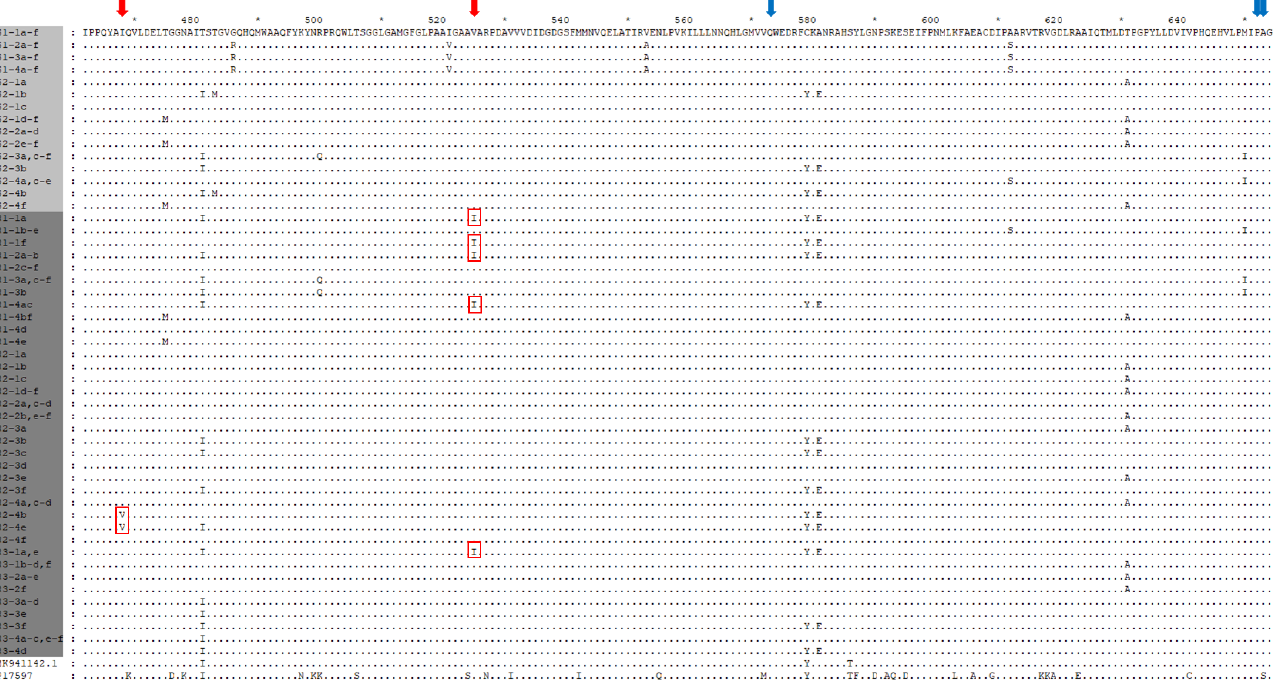
Figure 3. The alignment of Centaurea cyanus ALS amino acid sequences encompassing thiamine pyrophosphate binding domain. The sequences were derived from the plants susceptible (S) and resistant (R) to Lumer 50 WG. The numbers in sequence names represent the plant number; a–f—clone name; MK941142— C. cyanus ALS sequence GenBank accession number (the nucleotide sequence was translated to amino acid sequence); P17597— Arabidopsis thaliana ALS amino acid sequence GenBank accession number. The red frames and red arrows indicate amino acid mutations found in C. cyanus R plants. The blue arrows indicate the positions of mutations known for conferring resistance to ALS-inhibiting herbicides at positions W574, A653, and G654, respectively. The amino acid numbering refers to A. thaliana ALS sequence.